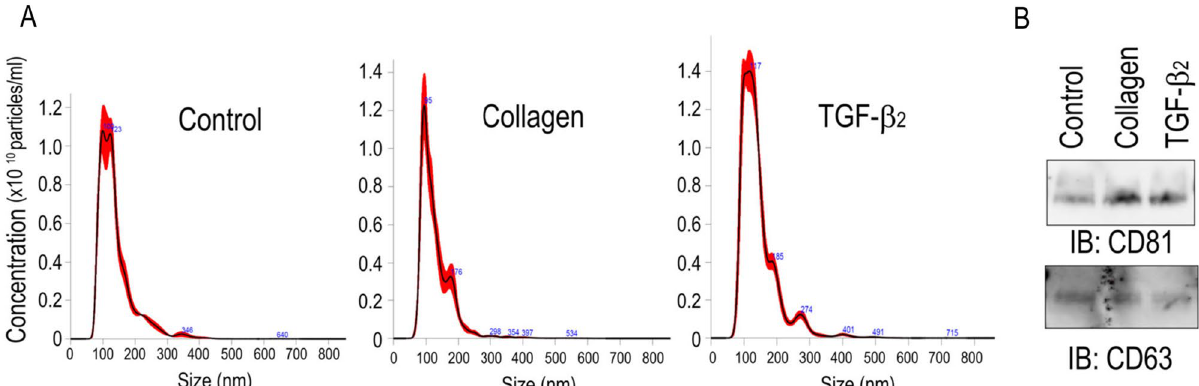
Figure 1. Purification of exosomes derived from monkey TM cells. Monkey TM cells were cultured in 10% exosome-free FBS with or without either Col-1 or TGF-β2 for 72 h, and exosomes in the supernatants were isolated using Exo-Quic-TC. ( A ) The concentration and size of exosomes were analyzed using a NanoSight analyzer. The standard deviation of five measurements of the same samples is shown in the red area. ( B ) Representative western blots of exosomes using antibodies against CD81 and CD63 (n =